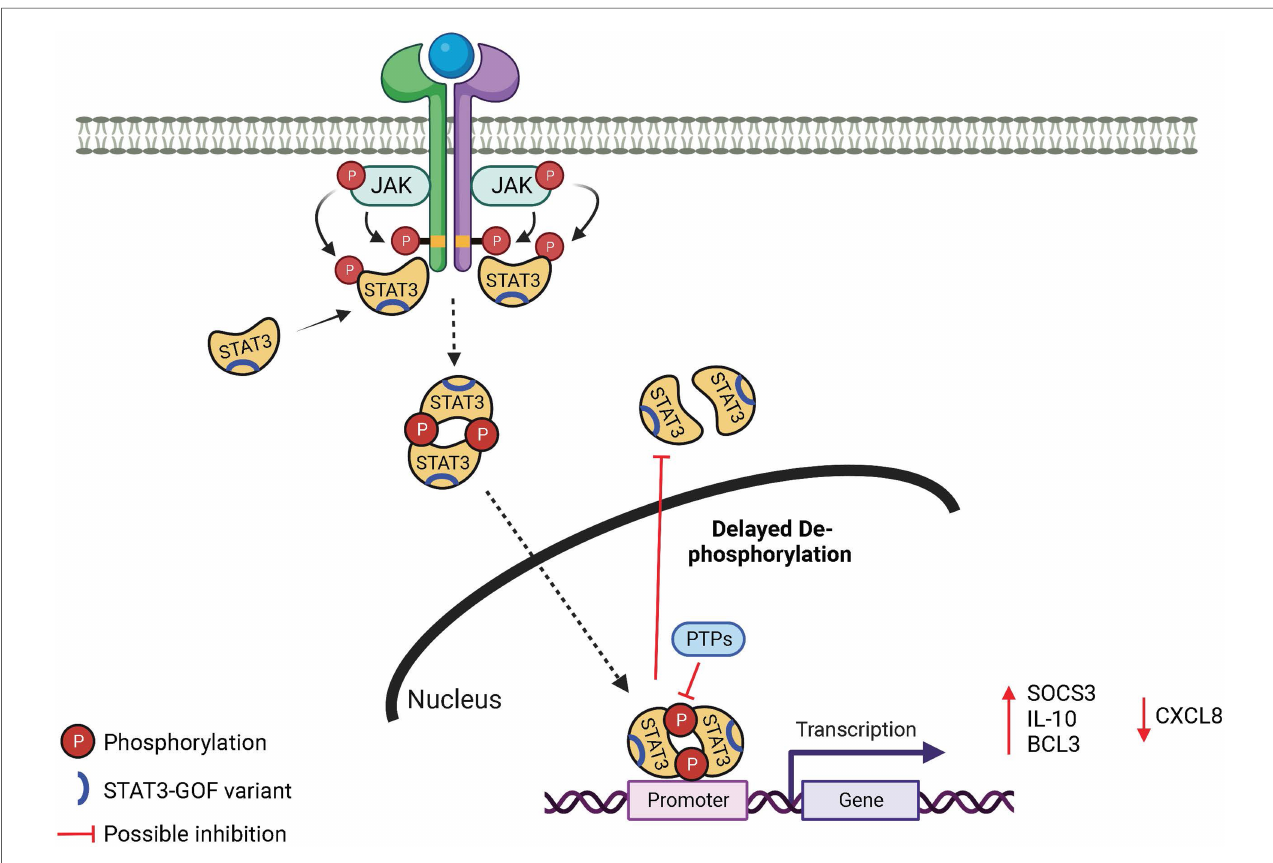
FIGURE 1 Mechanism in STAT3 GOF syndrome. JAK, Janus kinase; STAT, signal transducer and activator of transcription; PTP, protein tyrosine